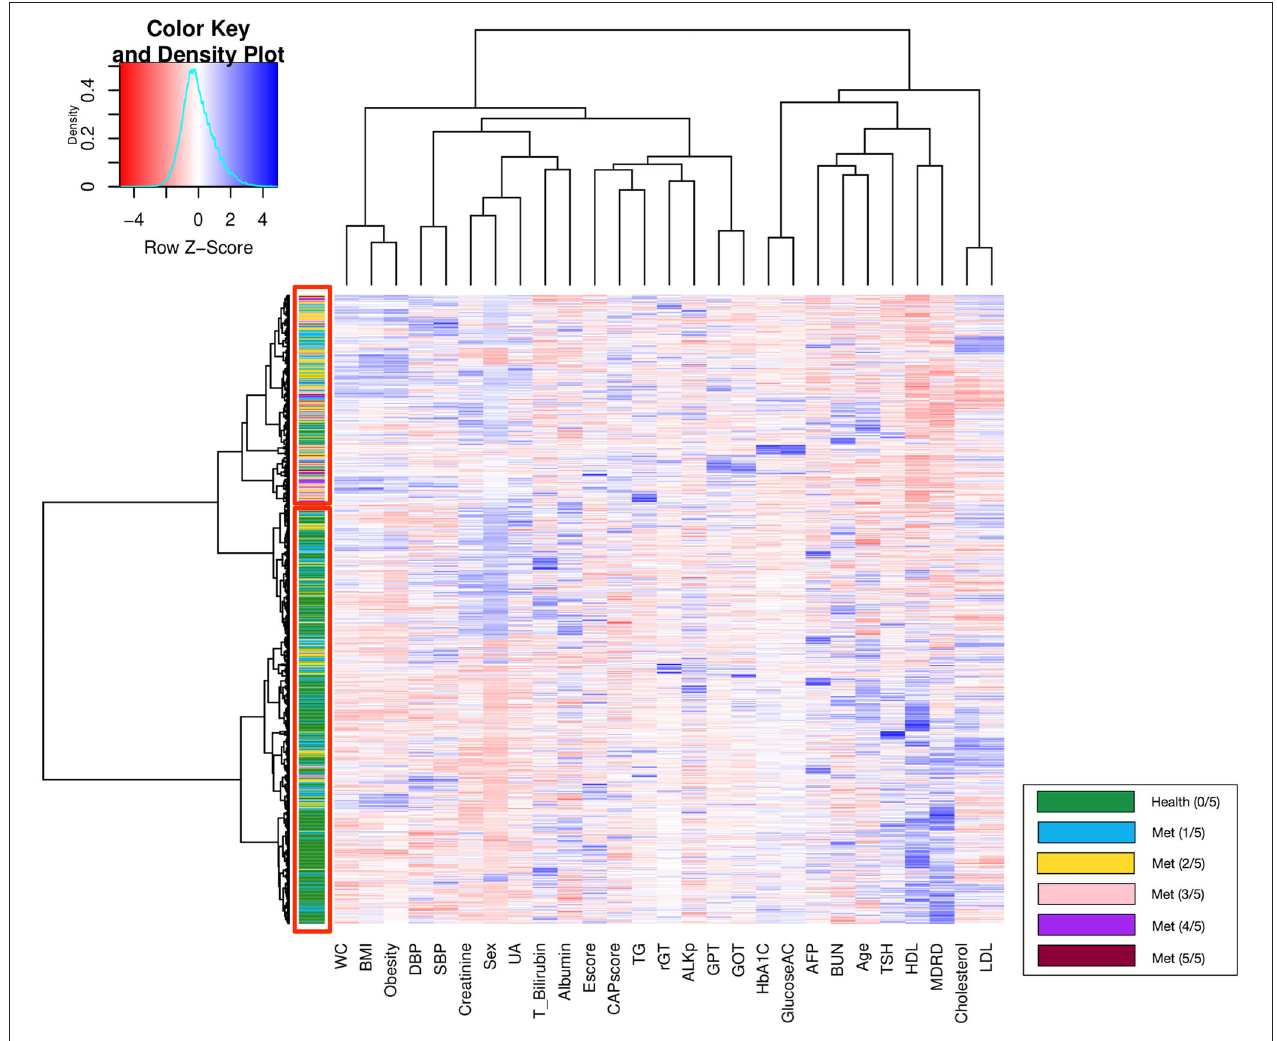
FIGURE 3 | Heatmap for clustering patients according to the results from the medical records.